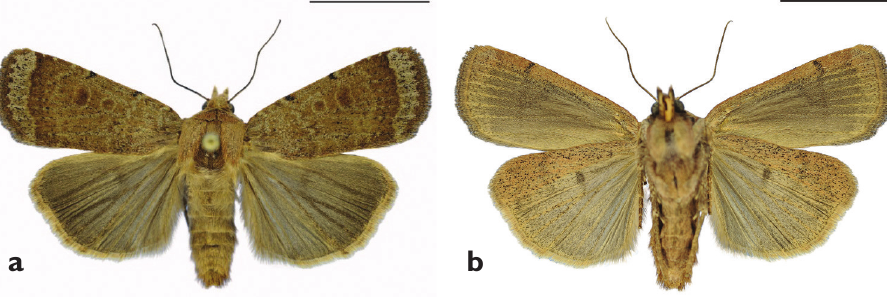
Figure 18. Abagrotis benjamini Franclemont, Dartmouth, MA. M.W. Nelson. a Dorsal b Ventral. Scale bars: 1 cm (Photos B.